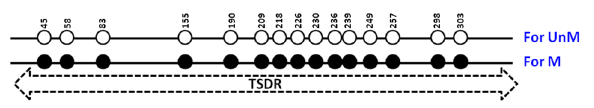
FIGURE 1 | Human TSDR of FOXP3. Schematic illustration of the amp-5 region of human TSDR of FOXP3 is showing the position of the 15 CpG sites. Solid circles represent methylated CpGs and open circles represent unmethylated CpGs. UnM, unmethylated; M,